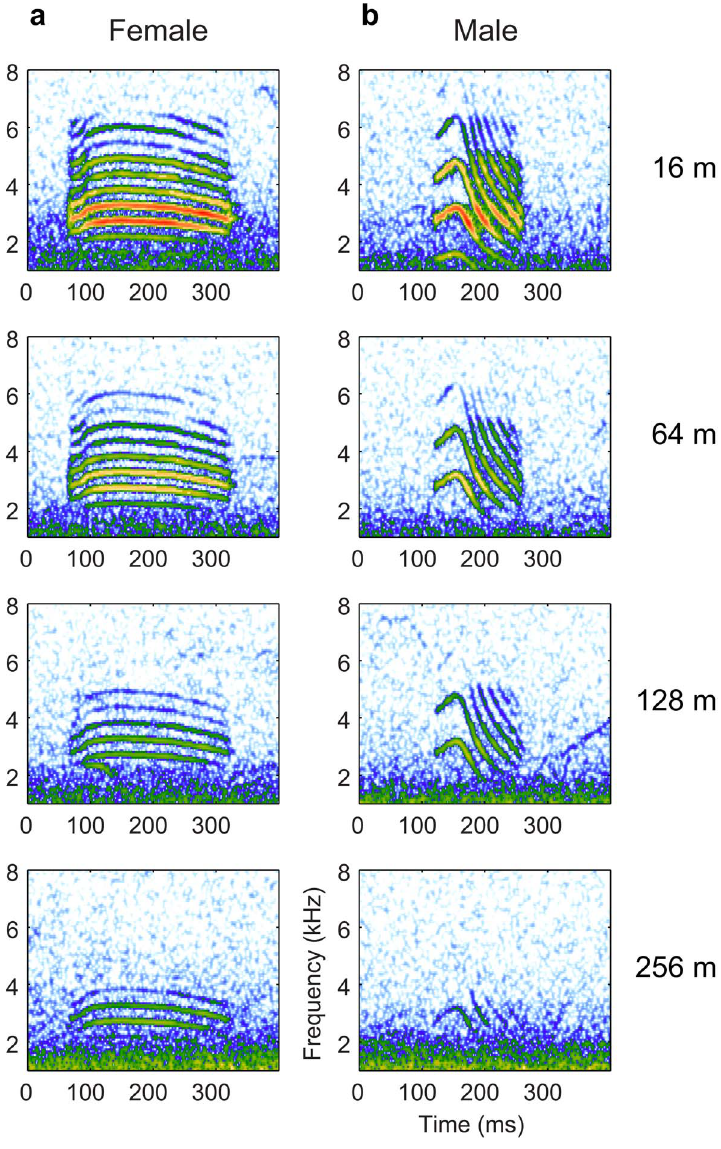
Figure 3. Spectrograms of the same female (a) and male (b) distance call recorded at various distances. All signals were high-pass filtered over 500 Hz, and the same color scale was applied to all